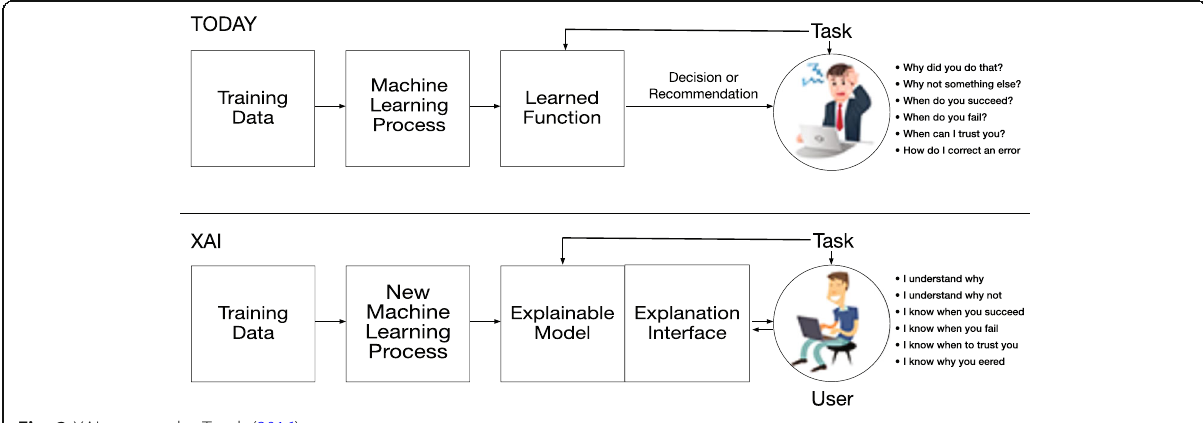
Fig. 2 XAI concept by Turek